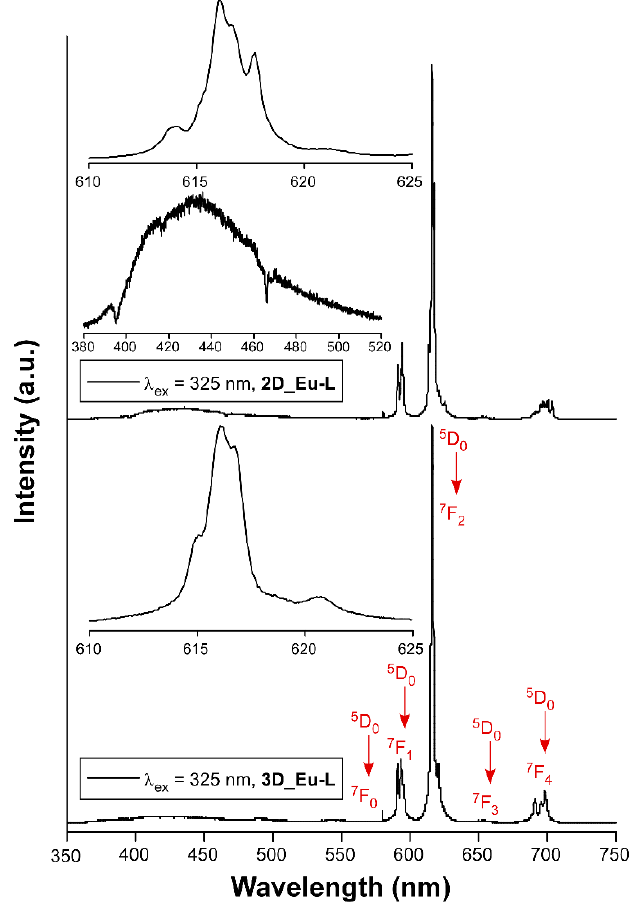
Figure 5. Emission spectra of Eu-based compounds recorded at room temperature showing the assig- nations and captures of the main intraionic transitions. Insets show augmented regions corresponding to the hypersensitive 7 F 2 ← 5 D 0 transition and the ligand-based